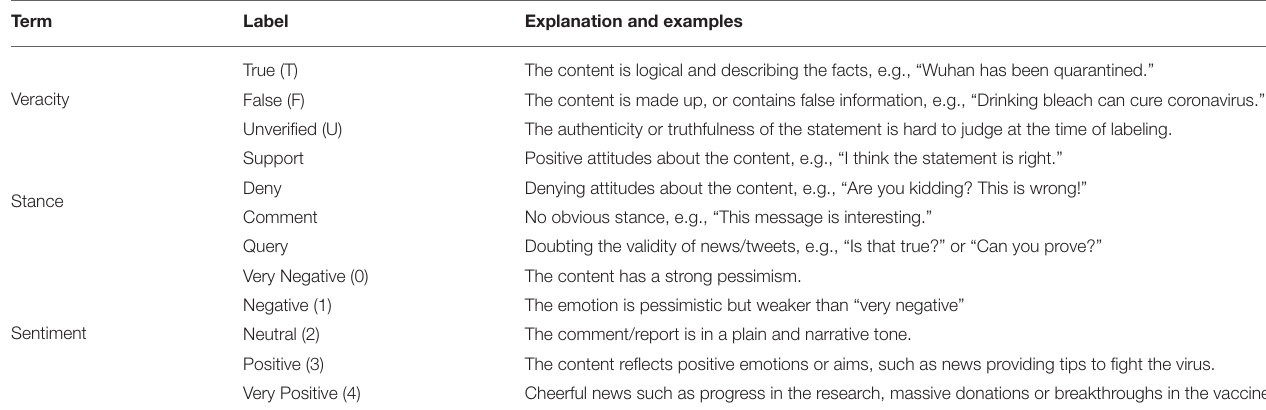
TABLE 2 | Demonstration of labels in the